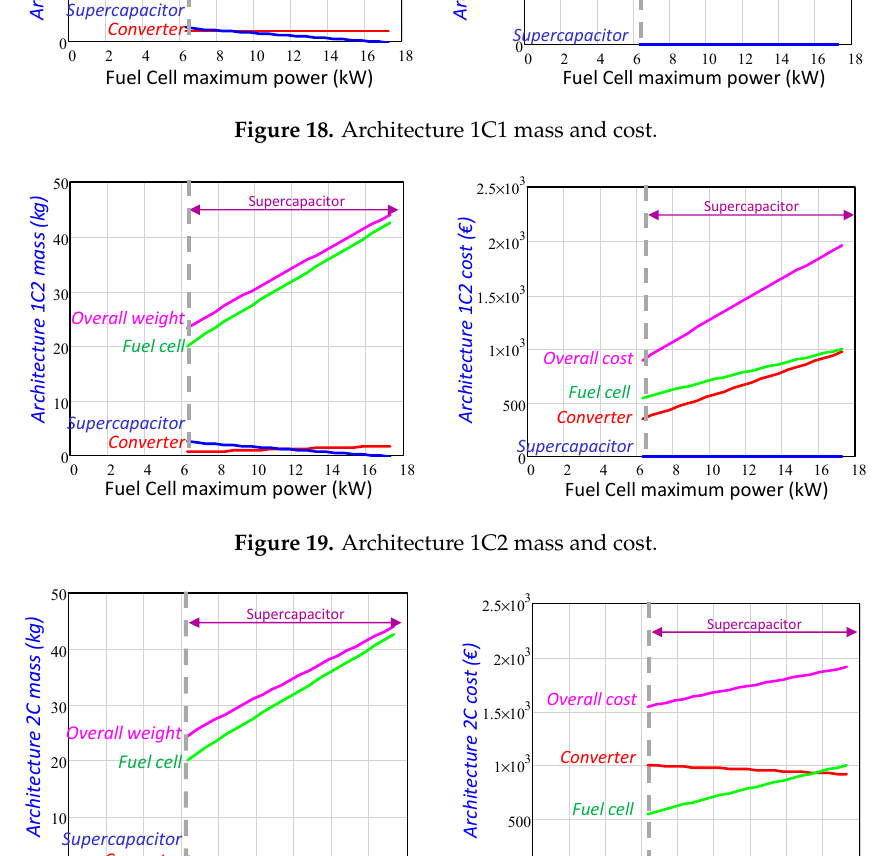
Figure 20. Architecture 2C mass and cost.